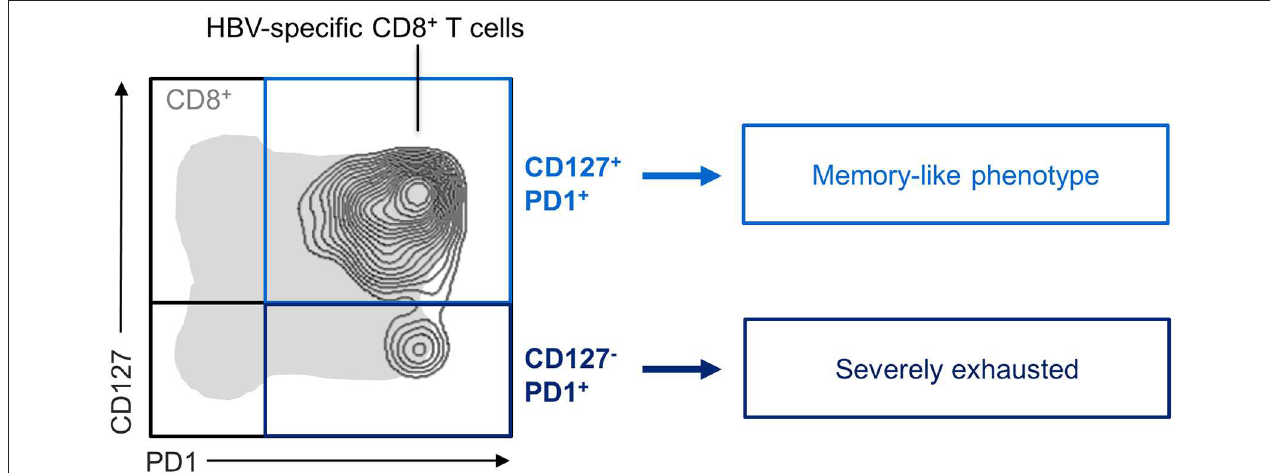
FIGURE 2 | Exhausted HBV-specific CD8 + T-cell subsets. CD127/PD1 co-expression analysis of exhausted HBV-specific CD8 + T cells showed the existence of distinct subsets. While HBV-specific CD8 + T cells were predominant in the CD127 + PD1 + memory-like subset, the more severely exhausted CD127 − PD1 + subset was also found in a small